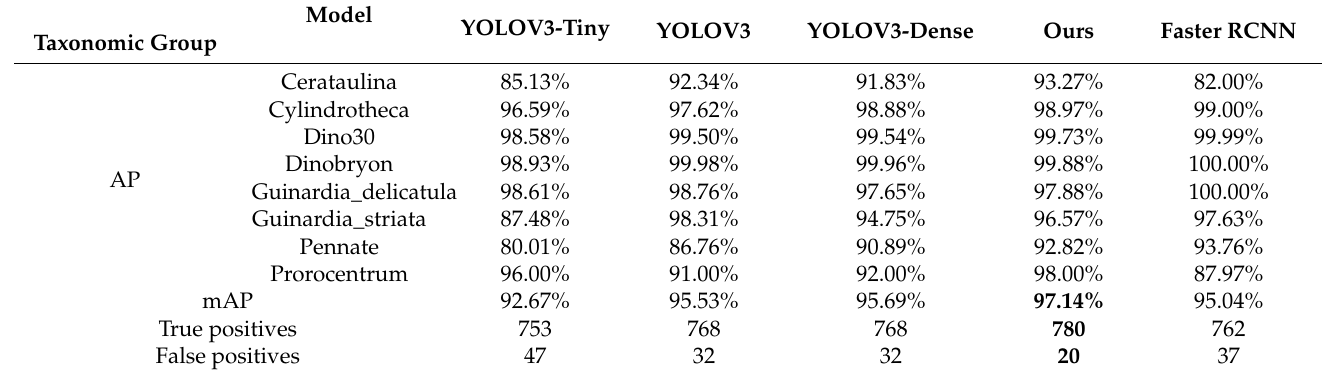
Table 5. Plankton detection performance of the proposed strategy and comparison models for the dataset in Table 3.